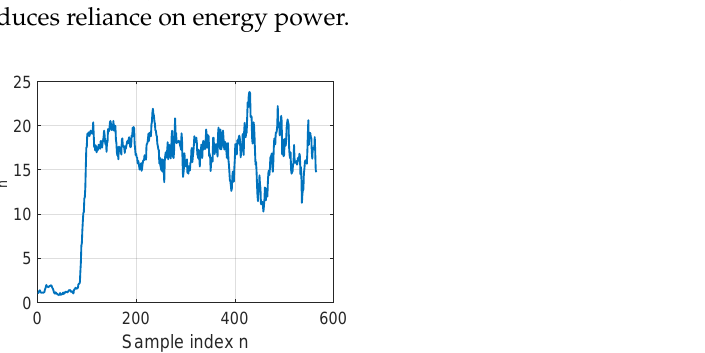
Figure 6. The response of received signal energy detection algorithm.